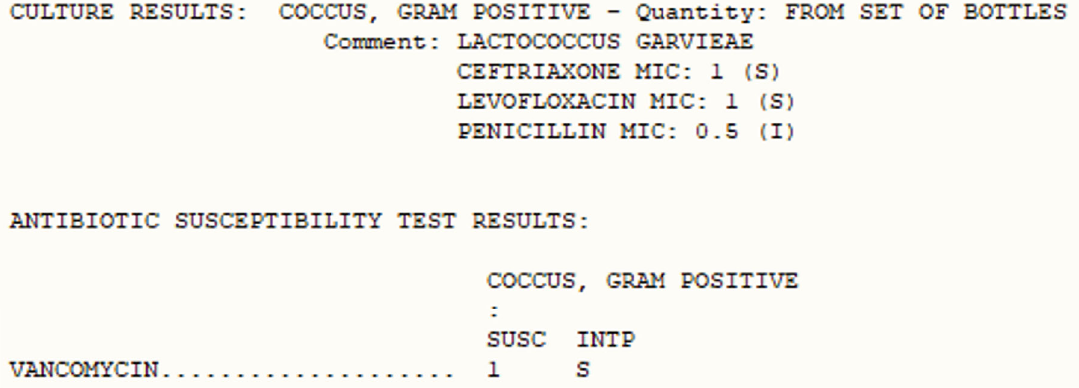
Figure 6: Lactococcus garvieae antimicrobial